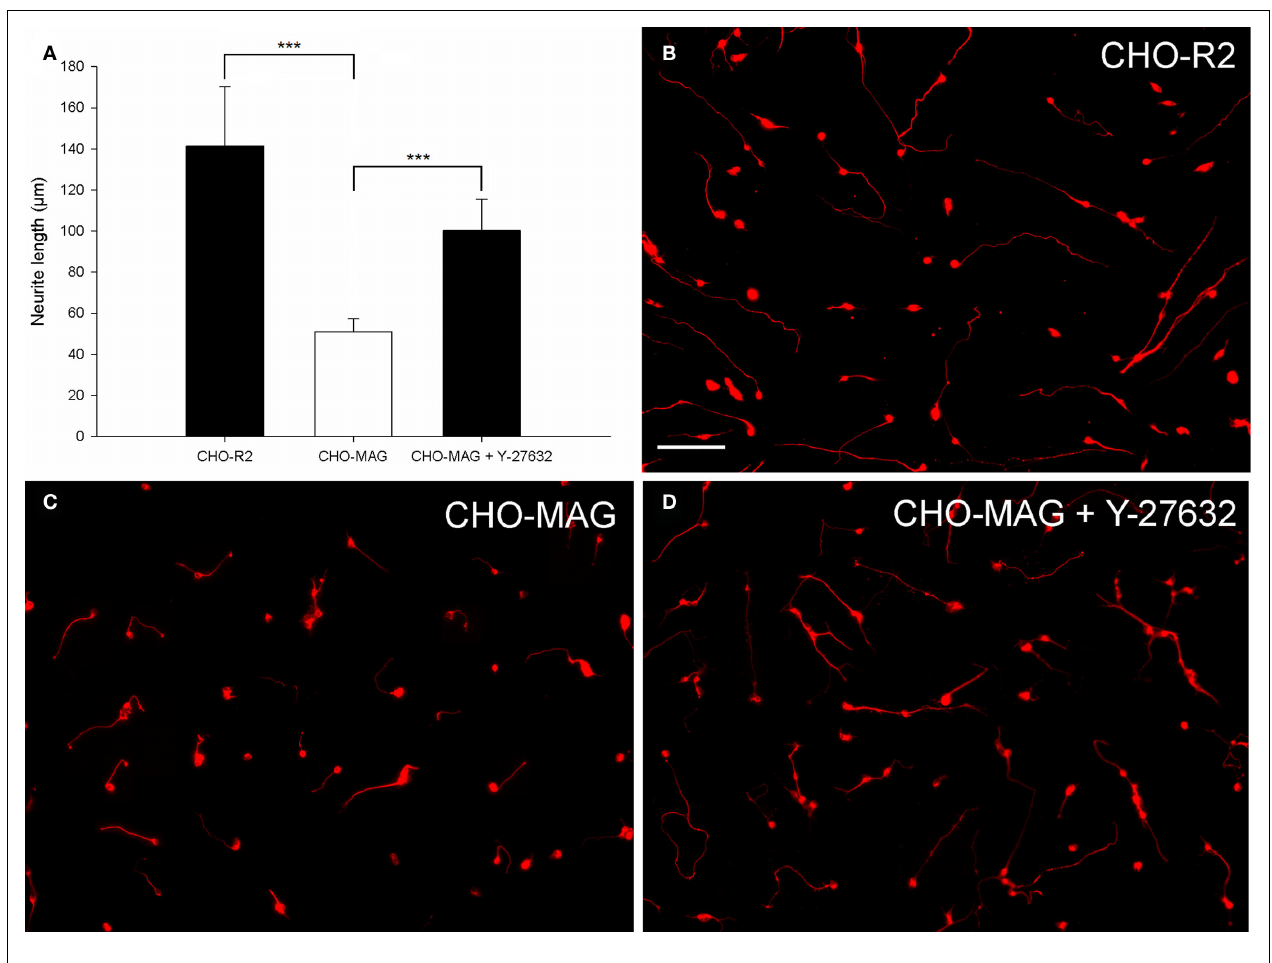
cultured on CHO-MAG cells in the presence ofY-27632 compared to CGNs cultured on CHO-MAG cells withoutY-37632.Values represent mean and SD; analysis was performed using one way ANOVA with Dunnett’s post hoc tests comparing to CHO-MAG cells ( ∗∗∗ P < 0.001), n = 8. (B) Non-inhibitory CHO-R2 cell substrate. (C) CGN neurite outgrowth is inhibited by the CHO-MAG cell substrate. (D) The ROCK inhibitorY-27632 reverses the MAG inhibition and promotes neurite outgrowth. Scale bar: 100 μ m. 1 pulse (190 ± 44 transfected CGNs; values represent mean ± SD, n = 8; Figure 2C ) with a transfection efficiency of 25% relative to the total number of surviving neurons. Applying more than 1 pulse did not result in a significant increase in transfection effi- ciency compared to the non-electroporated control ( Figure 2C ), which was probably a result of extensive cell death. The mean number of CGNs was significantly affected by pulse number [df = 3(28), F = 314.16, P < 0.001,one wayANOVA, n = 8]. Dun- nett’s post hoc test revealed that the mean number of CGNs was significantly decreased at all pulse numbers compared with the non-electroporated control ( ∗∗∗ P < 0.001, n = 8; Figure 2C ). Approximately 800 neurons per well were obtained with one pulse and percentage viability at 1 pulse was 53%. One pulse was